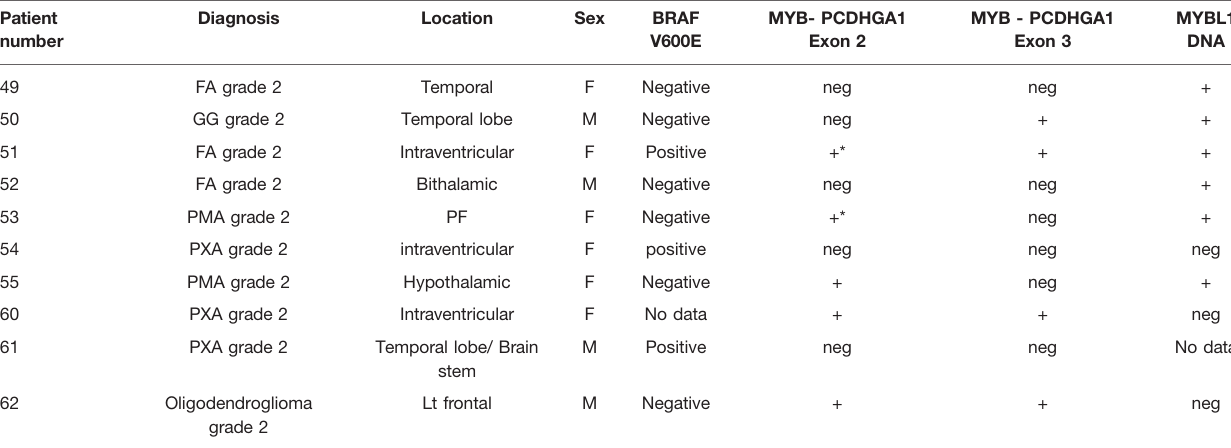
TABLE 3 | BRAF and MYB gene rearrangement.